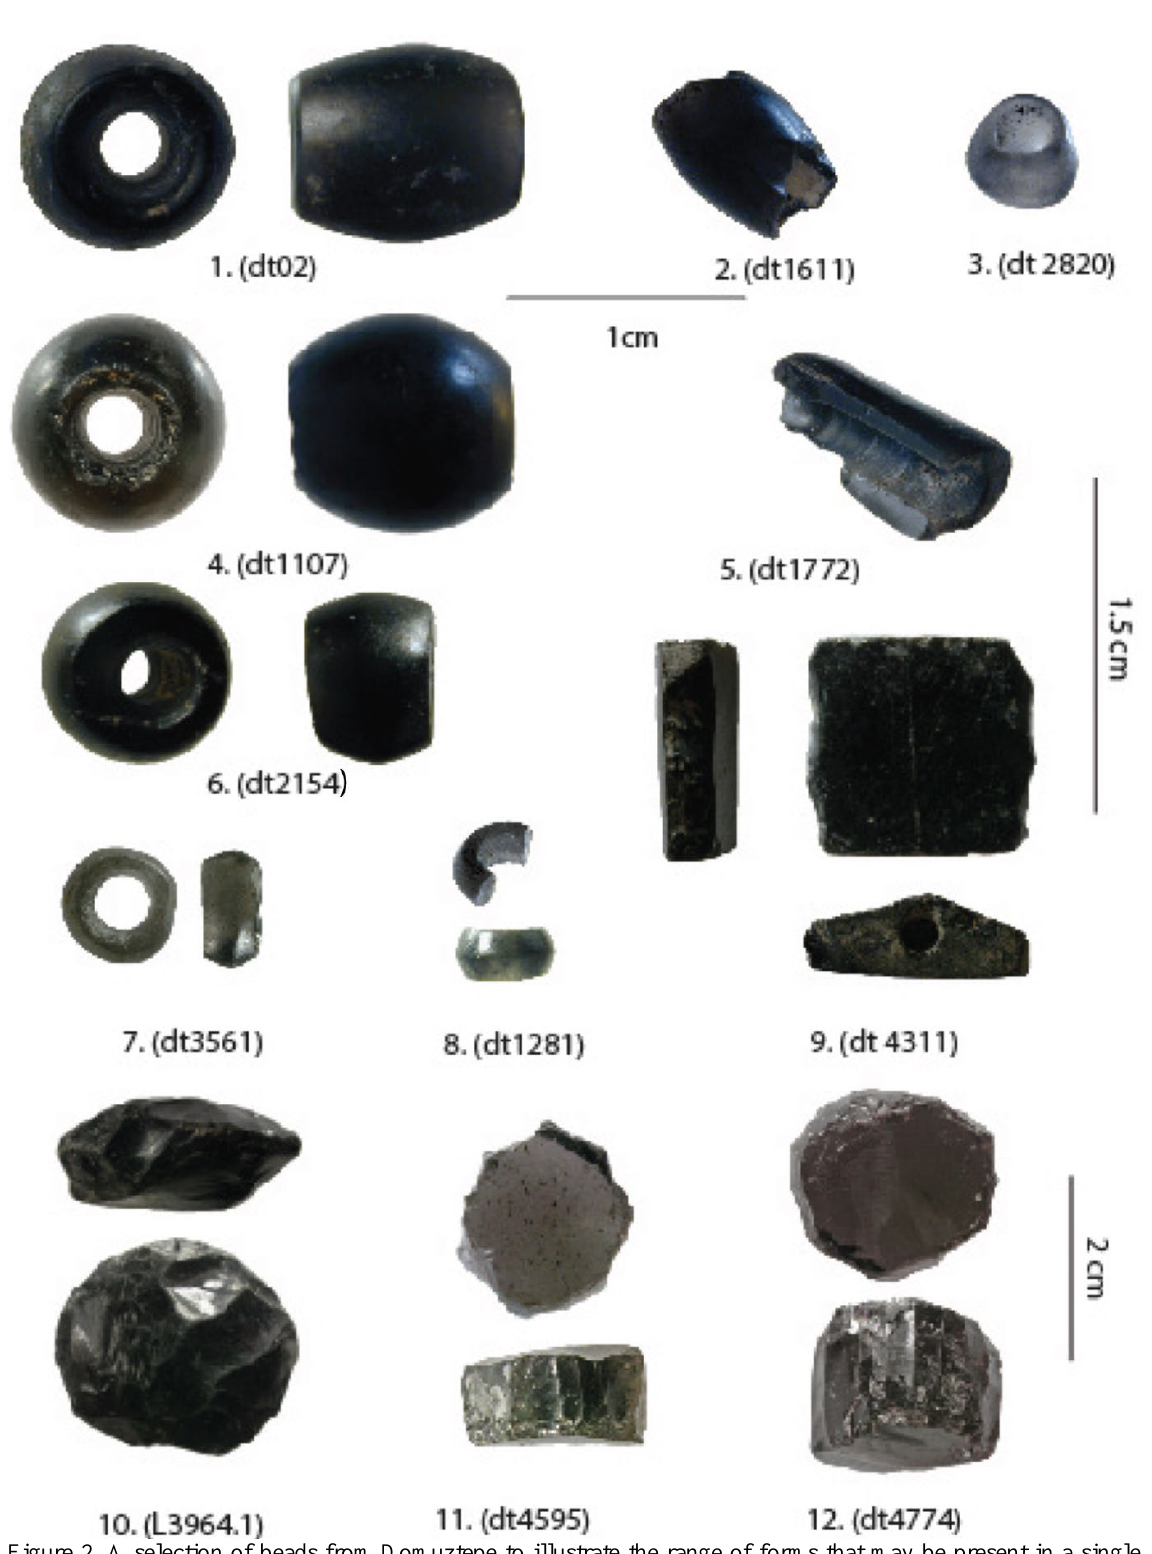
Figure 2. A selection of beads from Domuztepe to illustrate the range of forms that may be present in a single assemblage. All are from late Halaf ( c. 5800 BCE) contexts. Nos 3 and 5 from the Death Pit and nos 11 and 12 from the possible bead production area. Photographs courtesy of Stuart